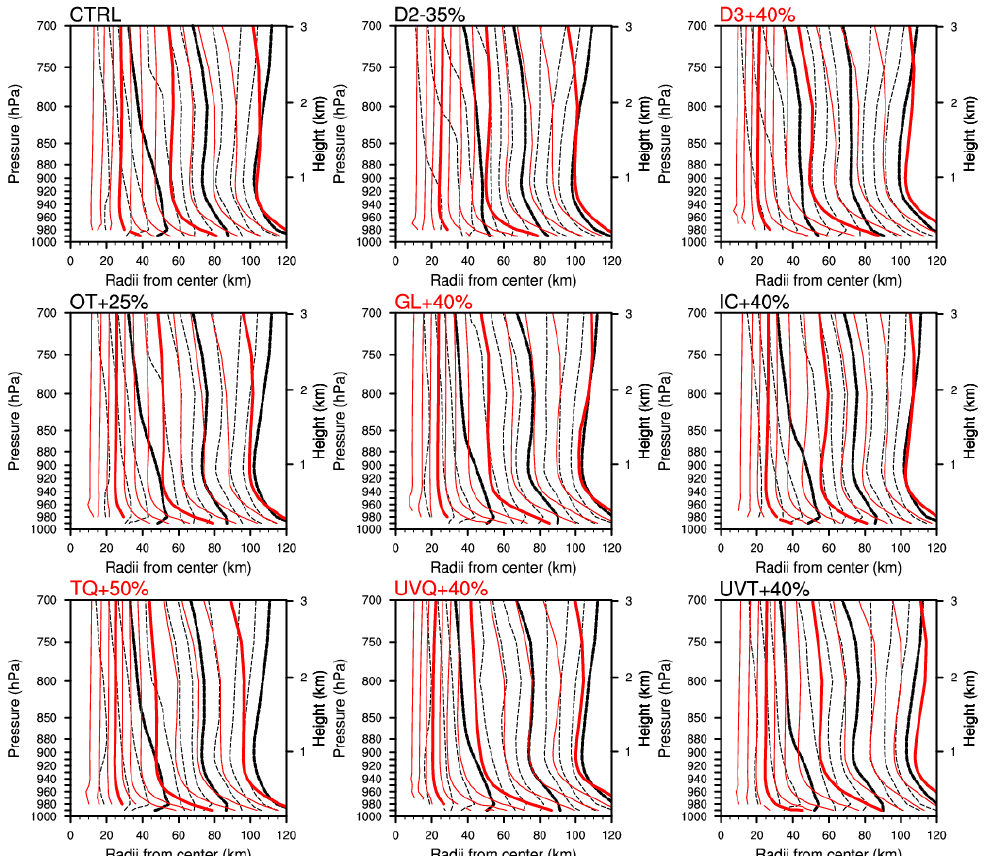
Figure 6. Radius–height cross-section of isopleths of absolute angular momentum at 06 UTC Sept. 26 (black) and in the period from 09 UTC 26 Sep to 00 UTC Sept. 27 (red). The contour interval is 2 × 10 5 m 2 s − 1 . Contours with values 8 × 10 5 m 2 s − 1 , 1.6 × 10 6 m 2 s − 1 , and 2.4 × 10 6 m 2 s − 1 are highlighted as thick curves.